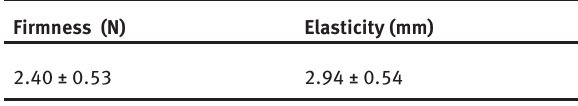
Table 2: Chromatic coordinates in physalis